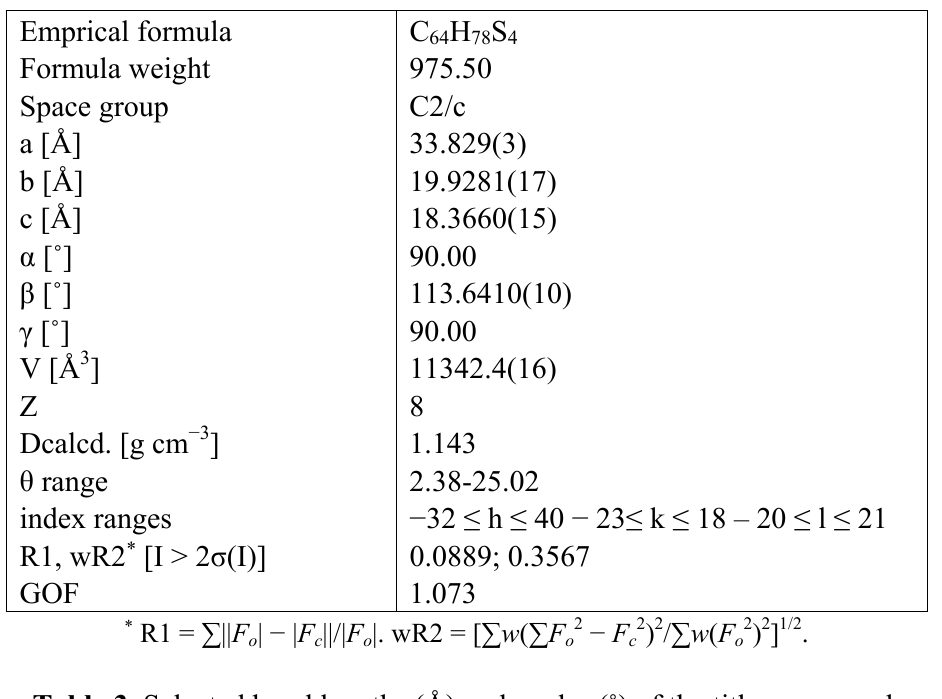
Table 3. Selected bond lengths (Å) and angles ( ˚ ) of the title